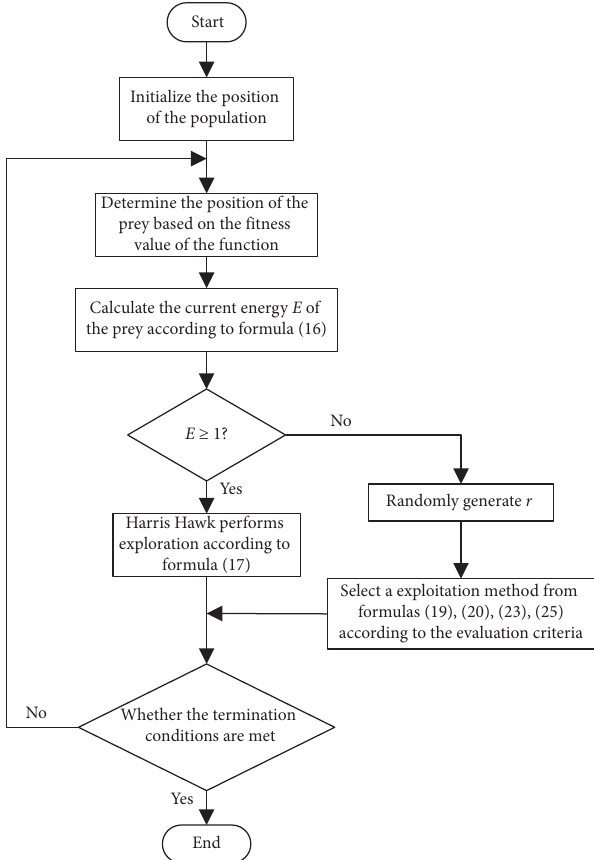
Figure 2: Procedure of HHO